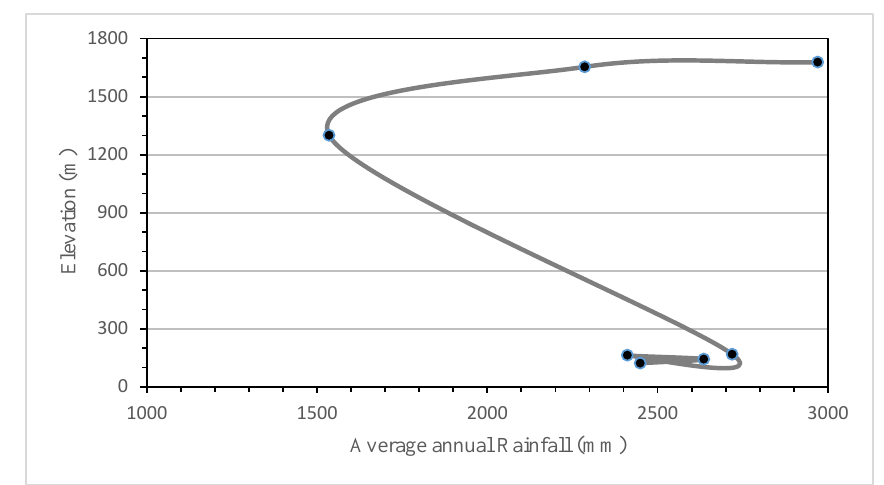
Figure 4. Comparison of annual average rainfall with the elevation of stations.